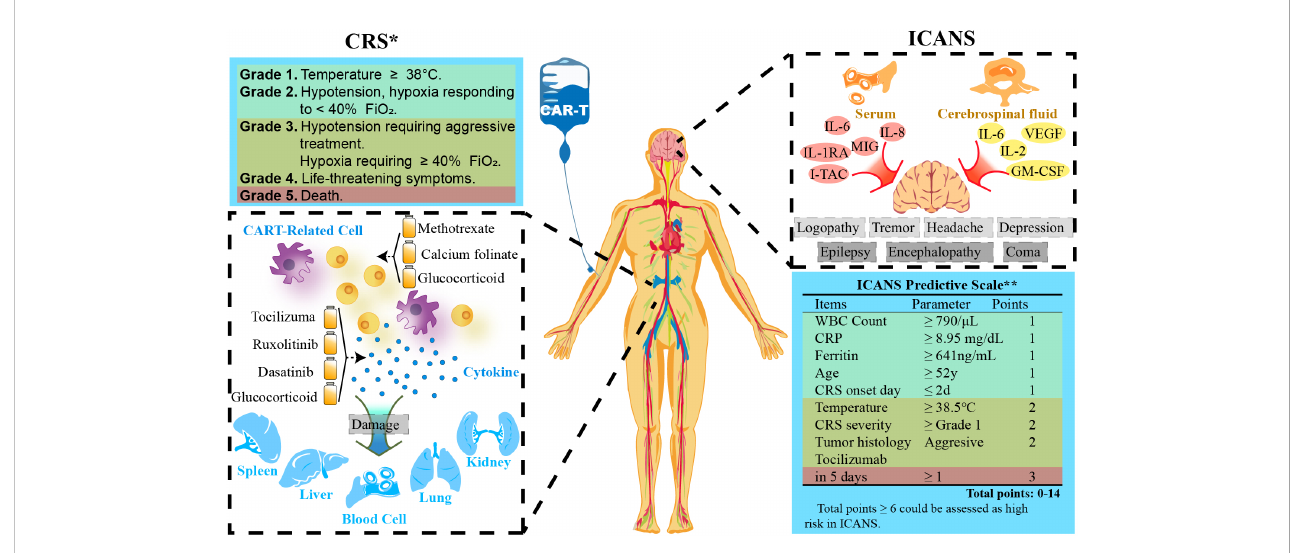
FIGURE 5 CAR-T cell therapy-related adverse events. *Grading is quoted from ASTCT (2018) (92). **Scale is referred from a study by Harvard Medical School (93). WBC, White Blood Cells; CRS, Cytokine Release Syndrome; CRP, C-reactive Protein; FiO 2 , Fraction of Inspiration O 2